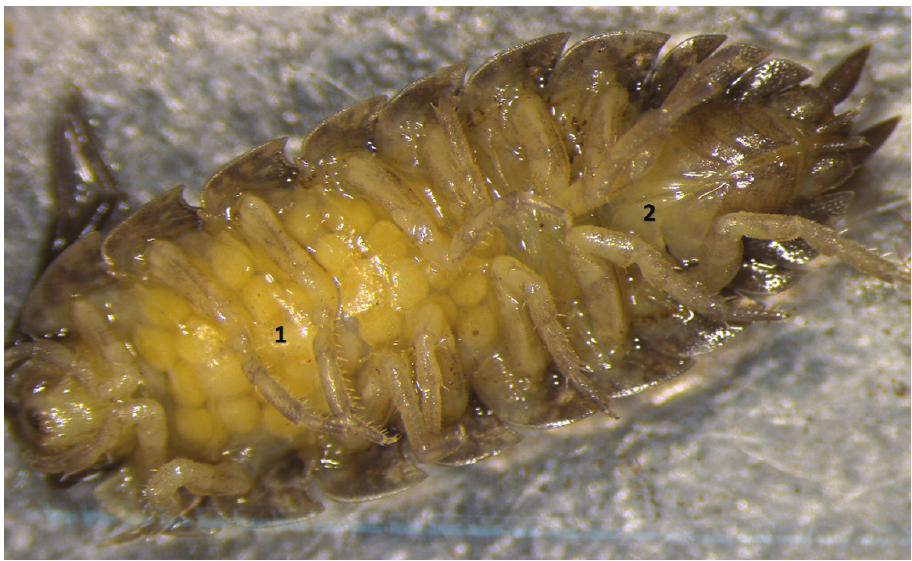
Figure 1. Ventral view of the intersex specimen of P. scaber with multiple eggs in the marsupium ( 1 ) and a male pleon ( 2 ).